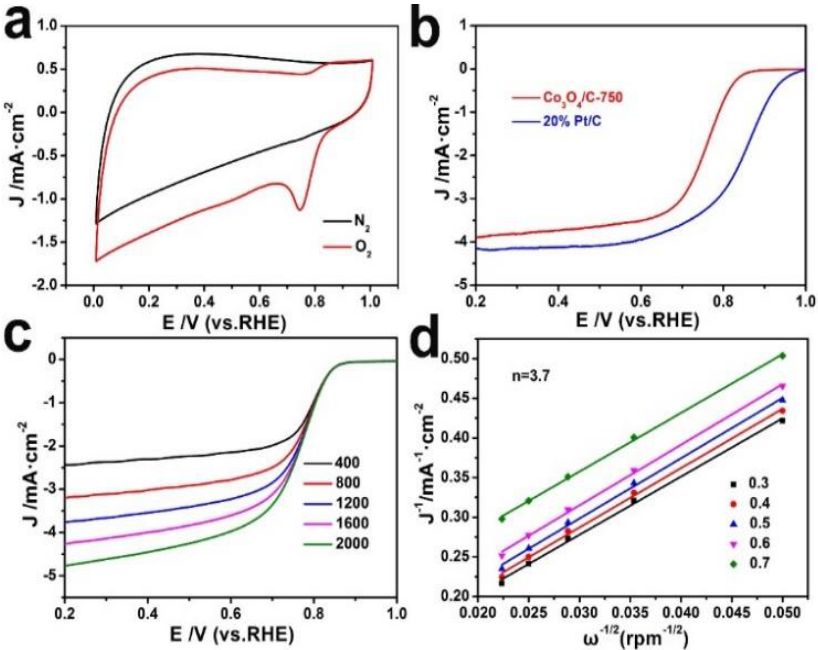
Figure 3. ( a ) CV curves of Co 3 O 4 /C − 750 in N 2 − (black trace) and O 2 − (red trace) saturated 0.1 M KOH solution at a sweeping rate of 50 mV · s − 1 , respectively. ( b ) LSV curves of Co 3 O 4 /C − 750 and 20% Pt/C in O 2 − saturated 0.1 M KOH at 1600 rpm with 10 mV · s − 1 sweep rate. ( c ) LSV curves for Co 3 O 4 /C − 750 at different rotation speeds (400–2000 rpm). ( d ) K − L plots of Co 3 O 4 /C − 750 at different electrode potentials (V vs. RHE).